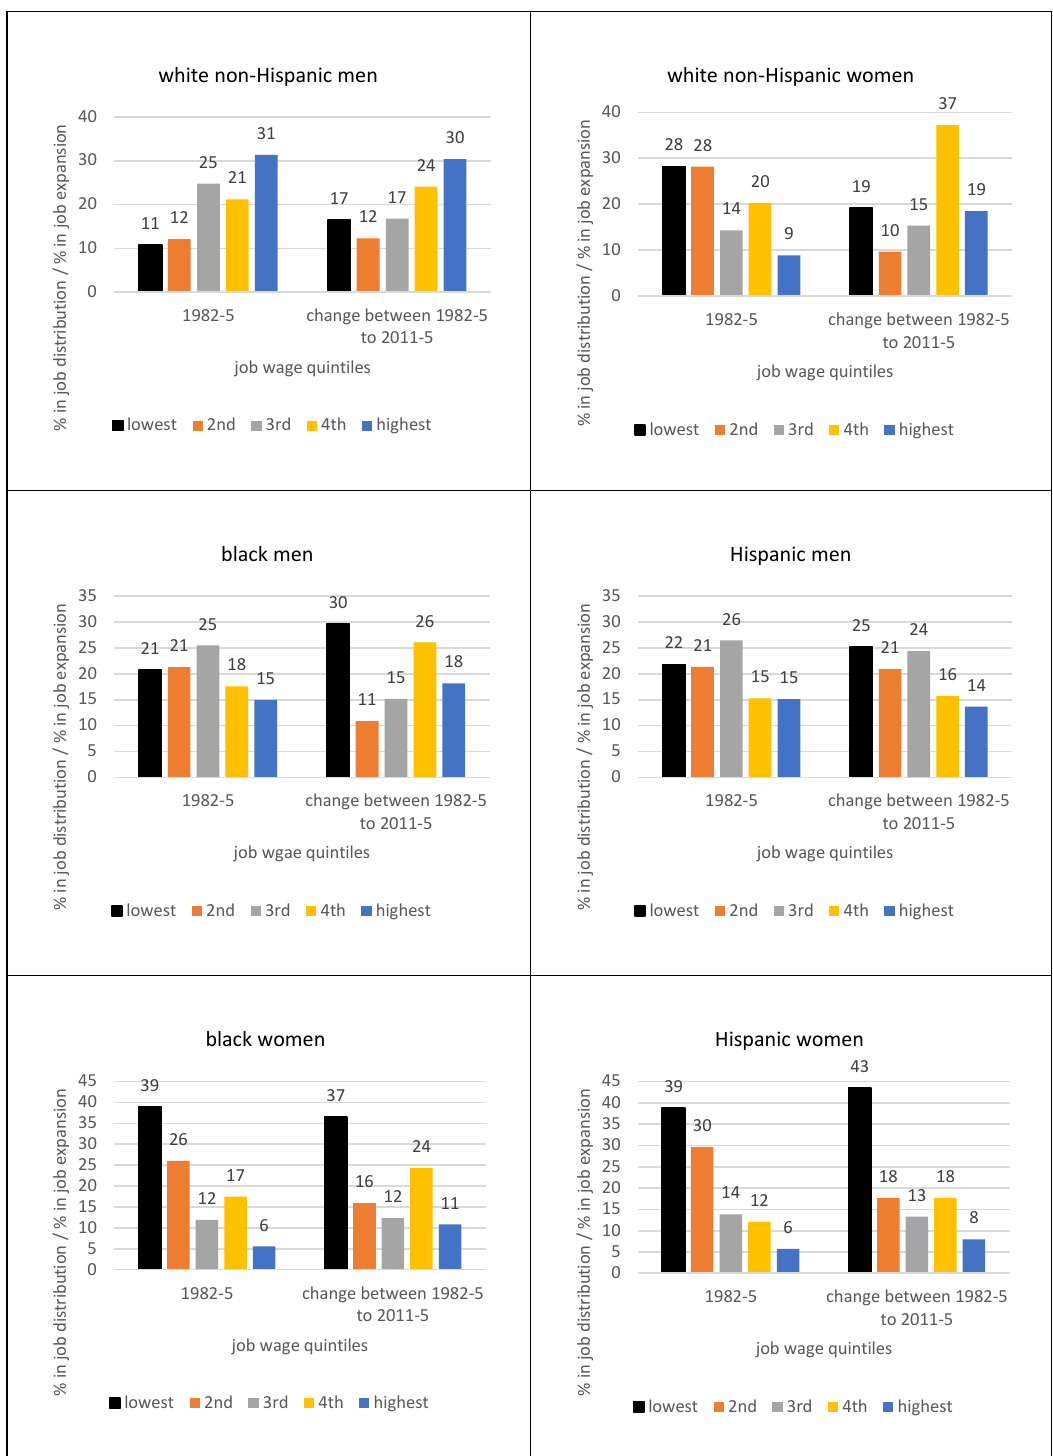
Figure 7: Job composition from 1982 to 1985 and patterns of job expansion between 1982 and 1985 and 2011 to 2015 among gender–race–ethnicity categories. Note: Private industry (and state and local government sector) wage and salary workers aged 18 to 65 who worked at least 20 hours per week and 26 weeks per year. sociological science |